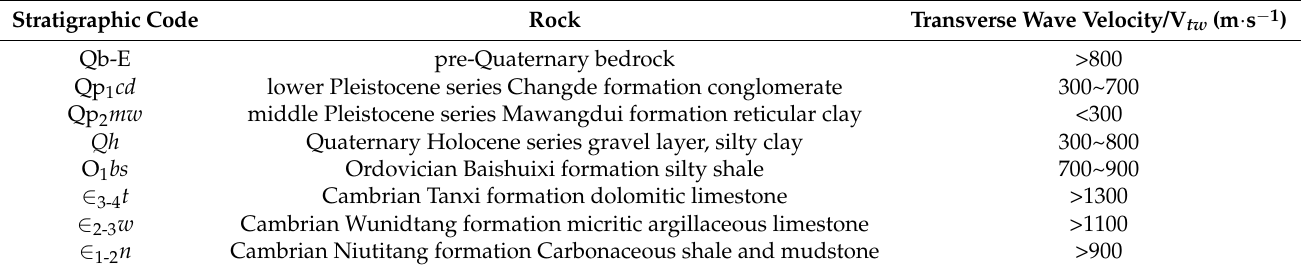
Table 2. S-wave velocity range of different strata in the study